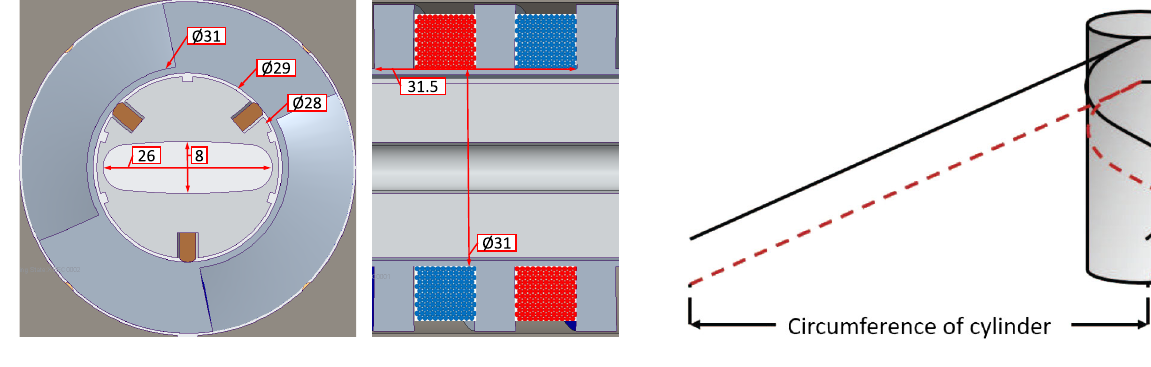
FIG. 3. Helix being formed by rotating a line with a slope around a